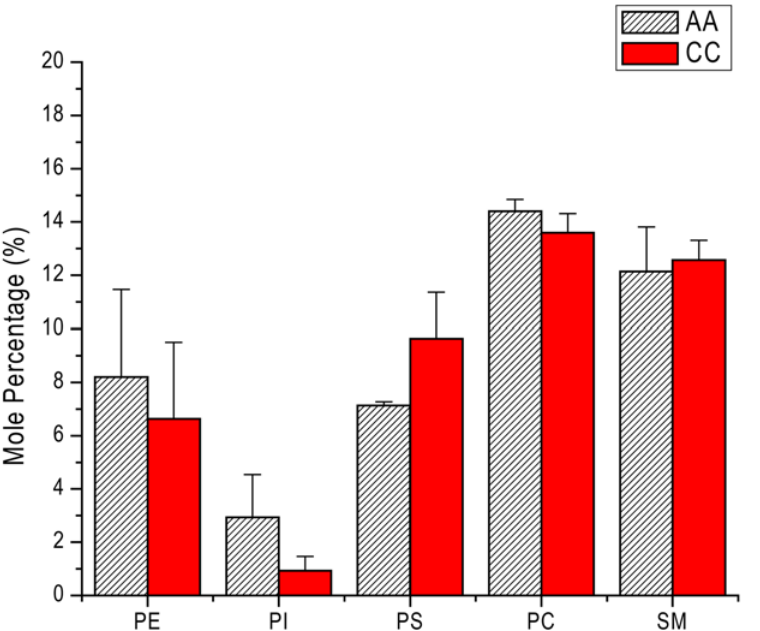
Figure 1. Lipid composition of AA and CC erythrocytes. All mean values are shown as mole % of total lipids including cholesterol. Error bars represent SEM (n=3).